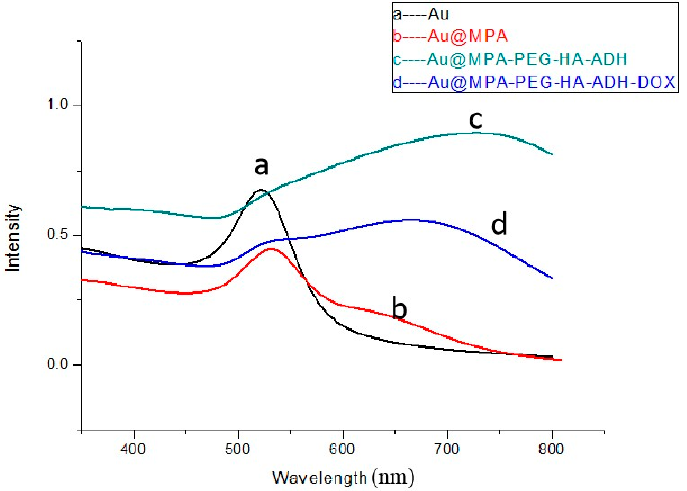
Figure 2. UV–Vis spectra of gold nanoparticles (AuNPs) before and after modification.